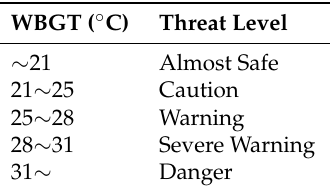
Table 2. Recommended criteria for thermal conditions.